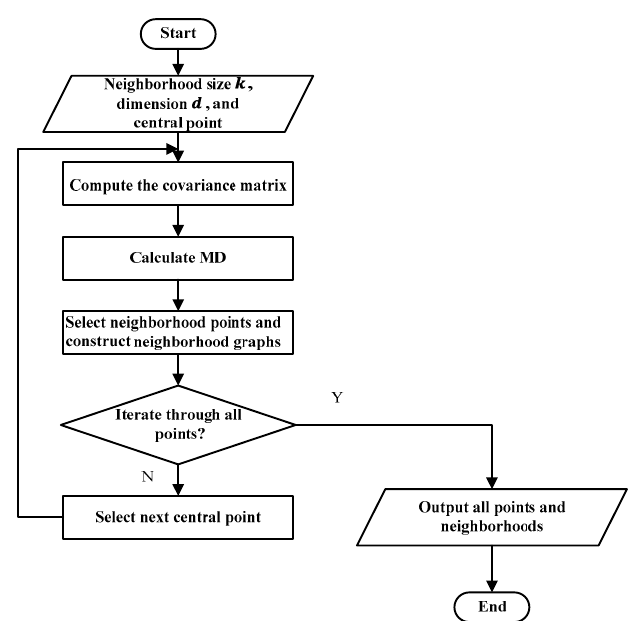
Figure 1. The flow diagram of neighborhood selection algorithm in M-Local Linear Embedding (LLE) algorithm.